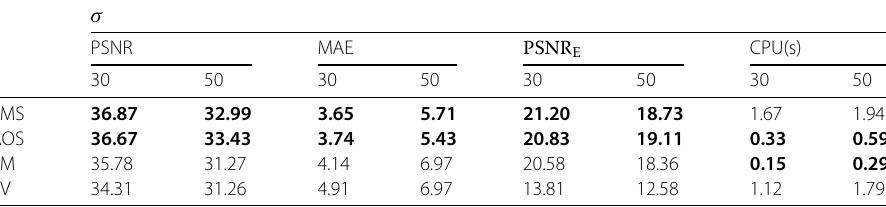
Table 1 PSNR, MAE, PSNR E , and CPU time (seconds) of all methods for the synthetic image